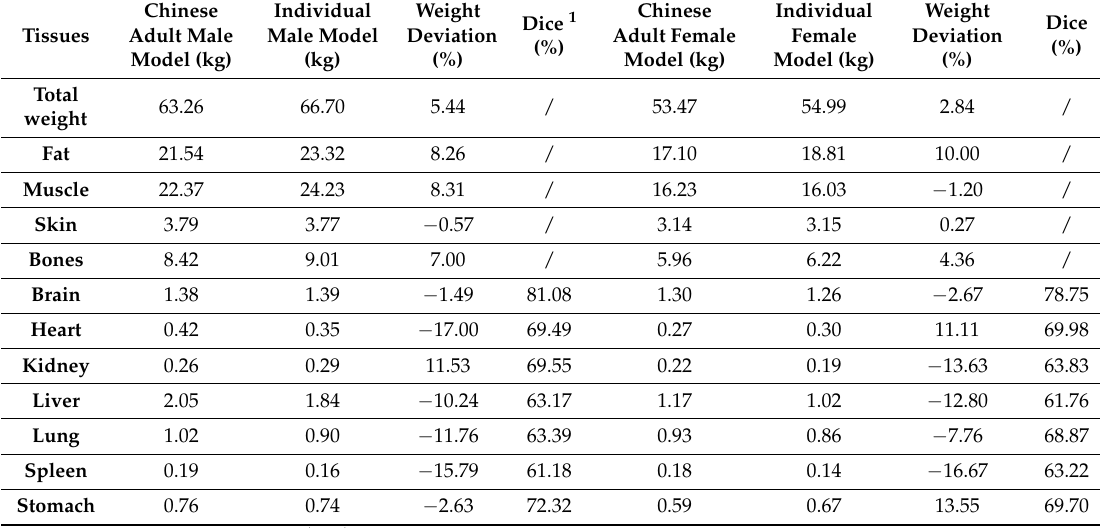
Table 3. Comparison for the major tissue/organs of the different models.